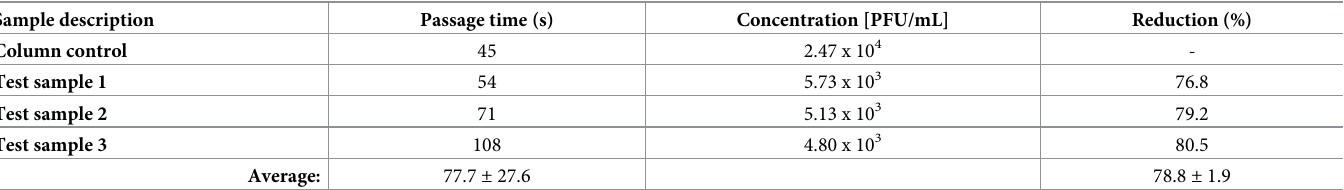
Table 6. NR-55672: Isolate hCoV-19USA/MD-HP05647/2021 (Lineage B.1.617.2; Delta Variant).